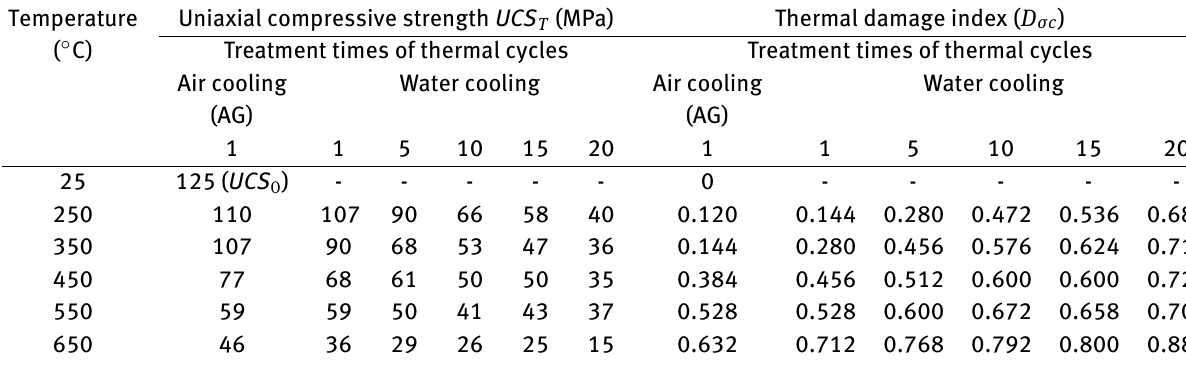
Table 2: Mean values of UCS and thermal damage index of specimens Temperature Uniaxial compressive strength UCS T (MPa) Thermal damage index ( D σc ) ( ∘ C) Treatment times of thermal cycles Treatment times of thermal cycles Air